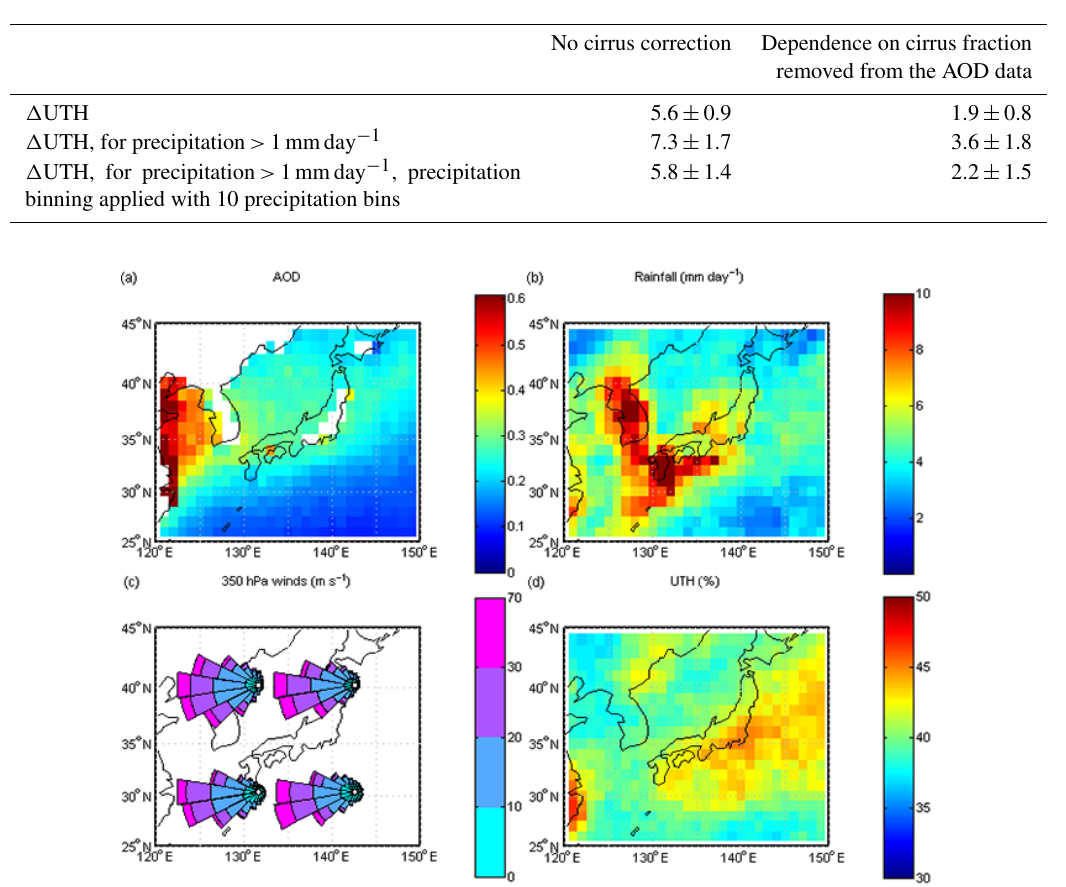
of AOD = 0.1486 × cf + 0.2535 and root mean square